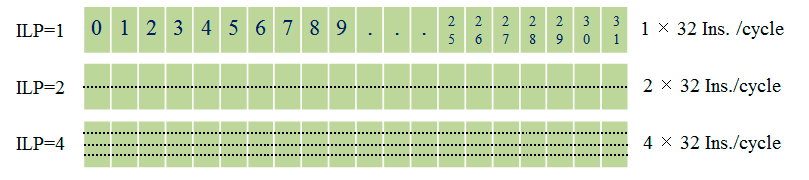
Figure 8. Intra-thread execution order simulation.